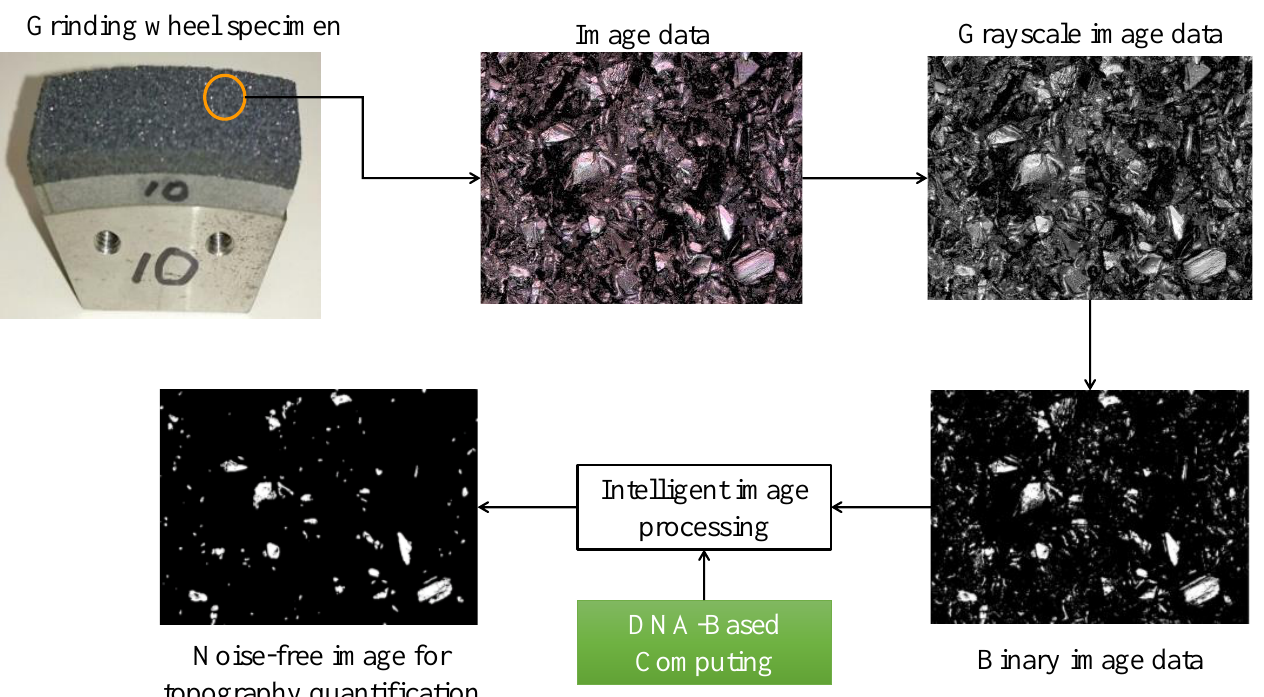
Figure 12. DBC-driven intelligent image processing for grinding wheel surface topography quan- tification.